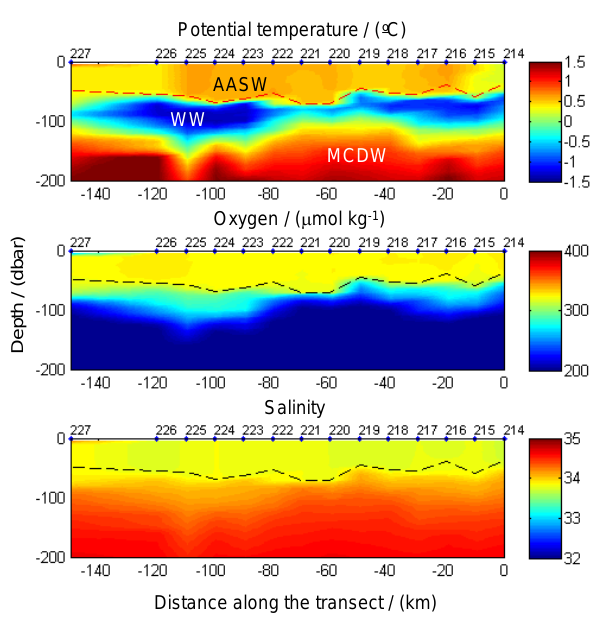
Fig. 5. Vertical sections showing the distribution of water masses for stations 214 to 227 in the west of the Adelaide Island area. The dashed horizontal line represents the bottom of the mixed layer as defined by the distribution of dissolved oxygen. AASW dominates the mixed layer, with WW beneath it and MCDW filling depths from